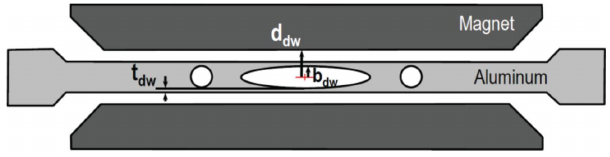
FIG. 4. Schematic layout of two magnet arrays (top and bottom) with magnetic field lines (courtesy of Clarke